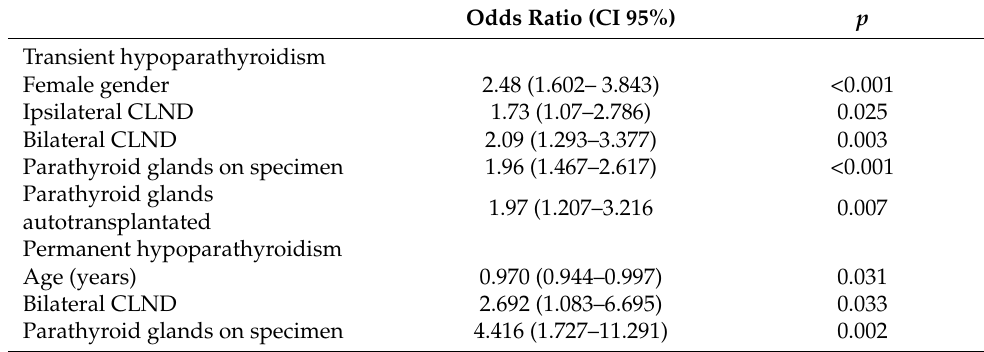
Table 4. Multivariate analysis of predictive factors associated with transient and permanent hy-